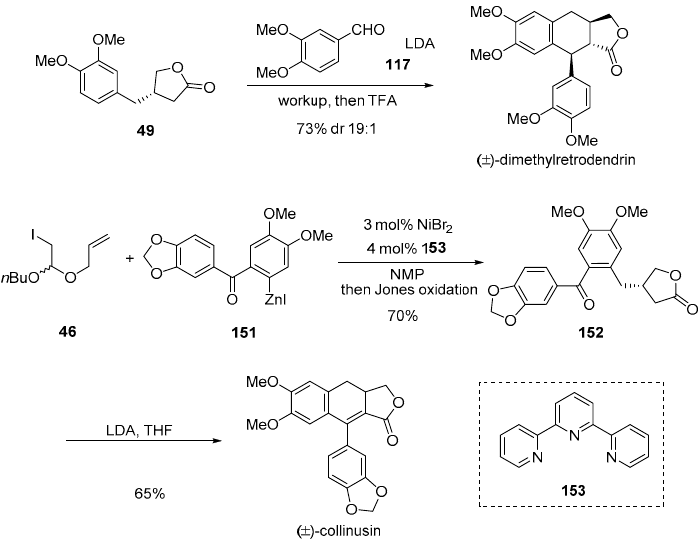
Scheme 26. Synthesis of (±)-dimethylretrodendrin and (±)-collinusin. Adapted from Giri et al.